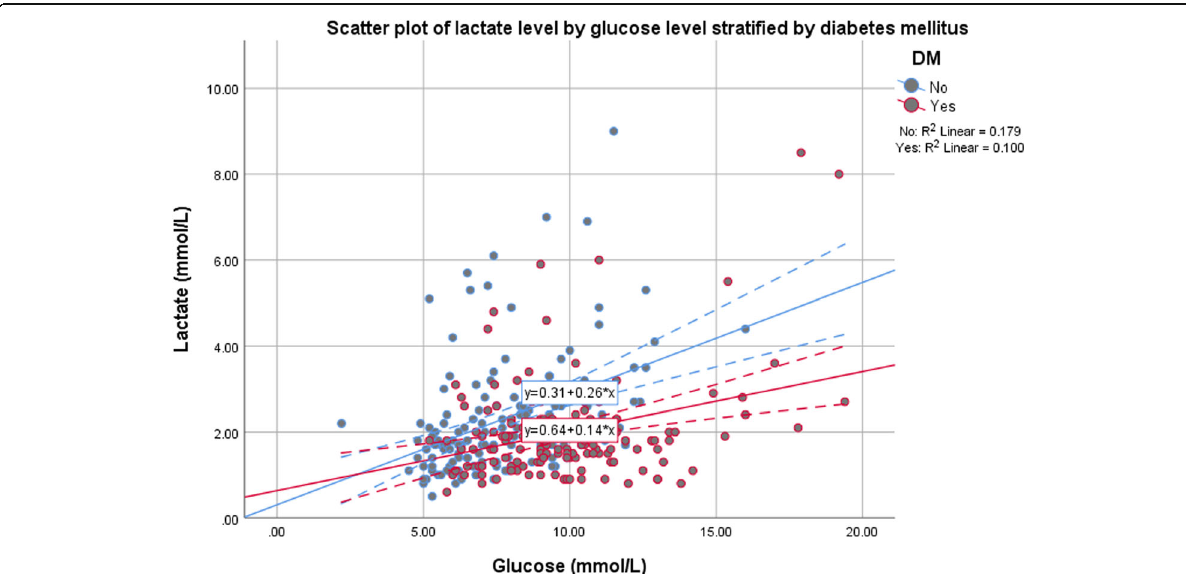
Fig. 2 Scatter plot for the relationship between glucose levels in mmol/L and the lactate levels in mmol/L stratified by diabetes mellitus. There is a positive relationship between the glucose level and the lactate level which is attenuated in patients with diabetes mellitus where a 1-mmol/L increase in glucose level is associated with 14 and 26% increase in the lactate level in patients with and without diabetes, respectively. The solid lines represent the fit lines for each category based on diabetes mellitus and the dotted lines represent the 95% confidence intervals.